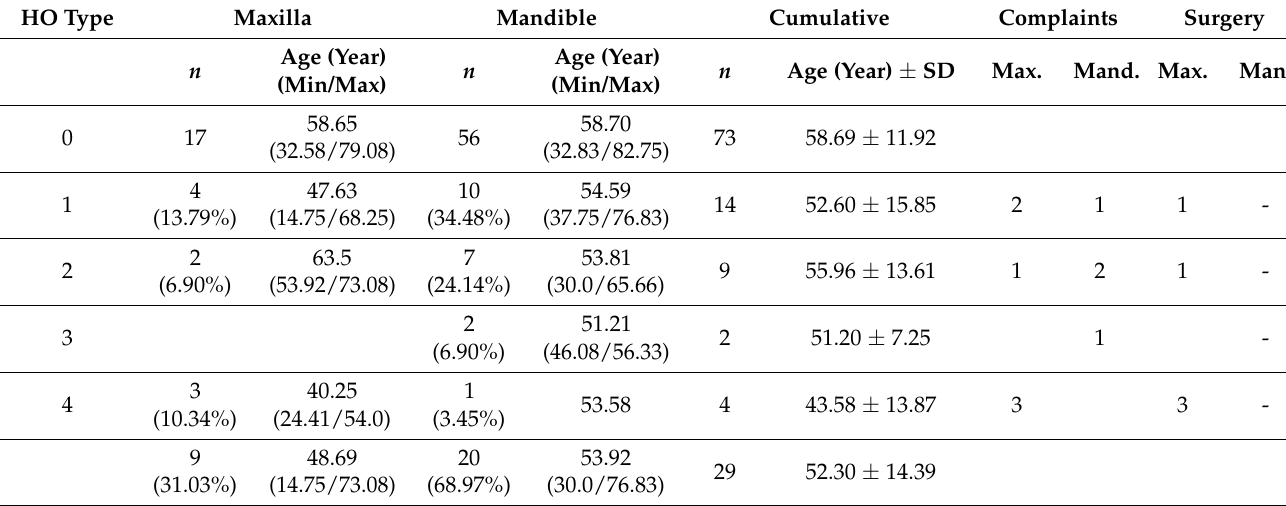
Table 2. HO was classified into four distinct radiological identifiable patterns. The distribution of HO types according to site of appearance (maxilla or mandible) and mean age (Minimum/Maximum), clinical impairments, and necessary surgical interventions are shown (Max., Maxilla; Mand., Mandible). HO Type Maxilla Mandible Cumulative Complaints Surgery